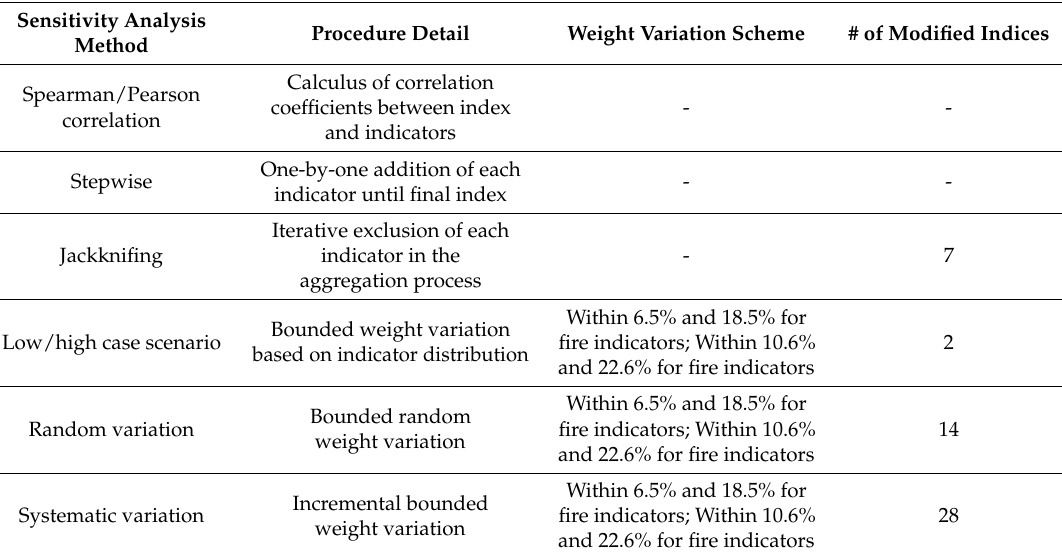
Table 2. Details pertaining to each sensitivity analysis method.